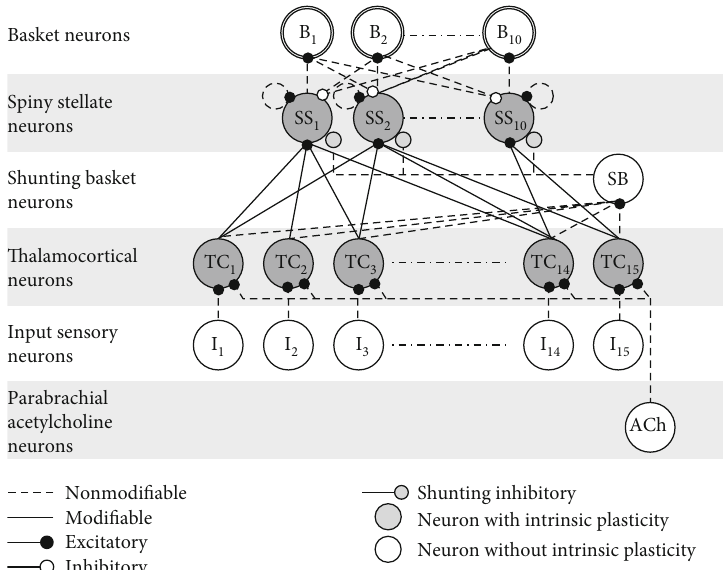
Figure 2: Cytoarchitecture of the koniocortex network in which acetylcholinergic neurons from the parabrachial nucleus project to thalamocortical neurons. The neurons that speci fi cally belong to the koniocortex are the spiny stellate (SS) neurons, the inhibitory basket neurons (B), and the shunting basket (SB)